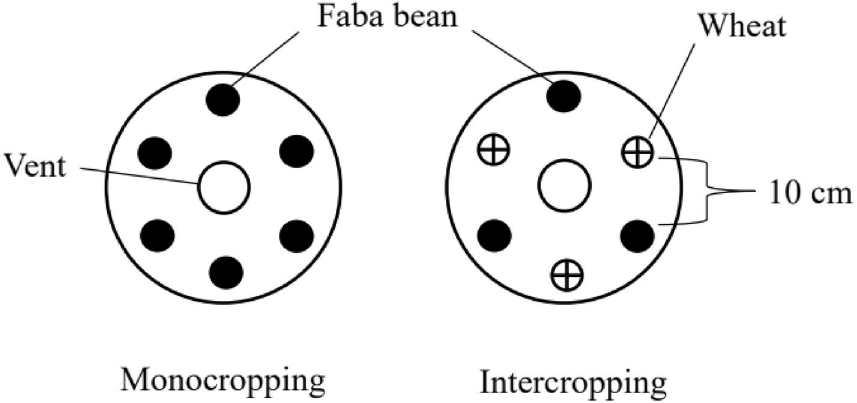
Figure 4. Diagram of the planting patterns in the